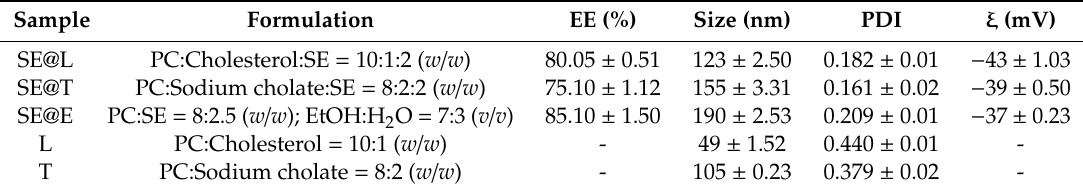
Table 1. The characteristics of Sambucus ebulus (SE) extract-loaded lipid